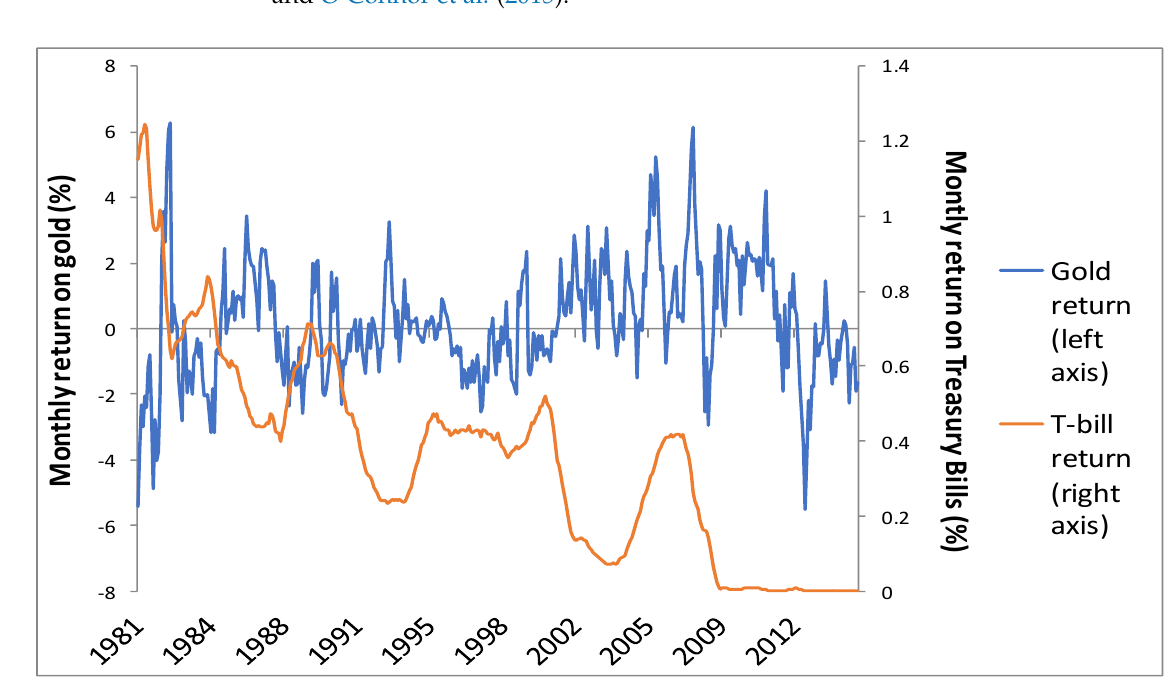
Figure 1. 6 month moving averages of the 1-month return on gold and Treasury bills from January 1981 to December 2015.